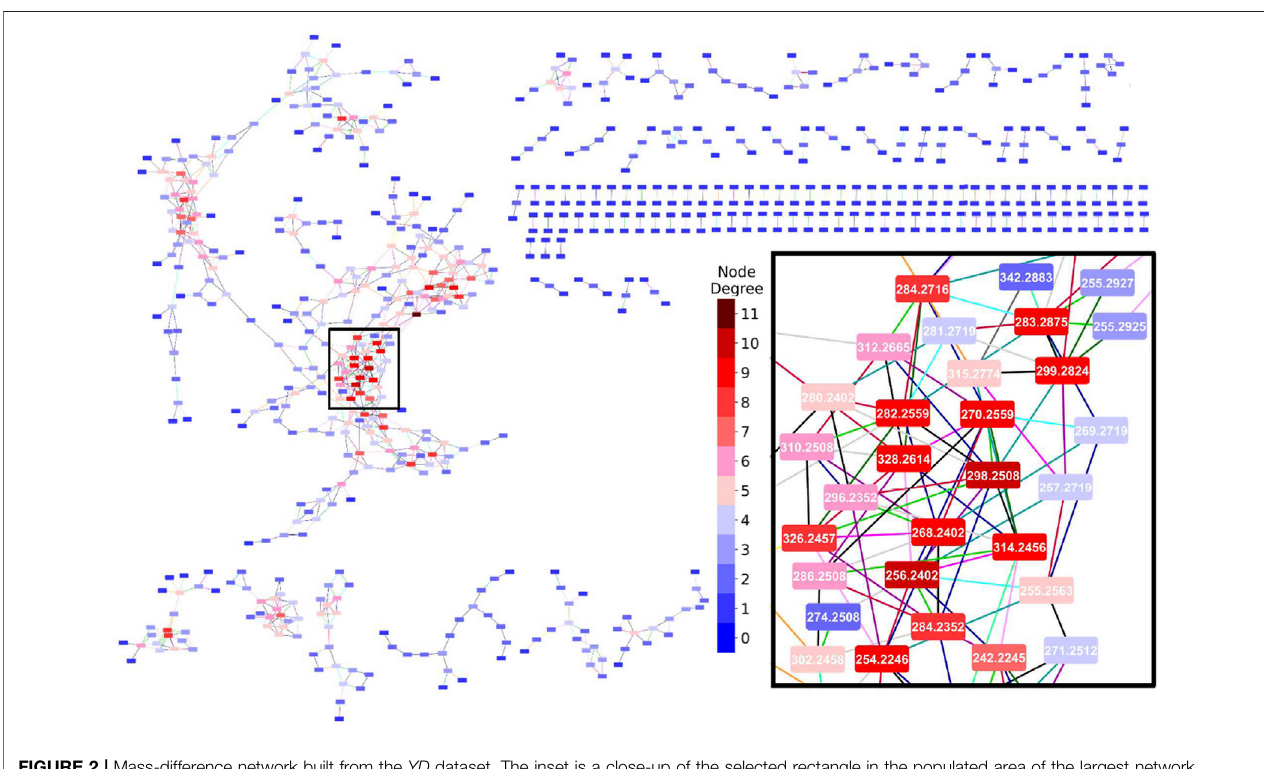
FIGURE 2 | Mass-difference network built from the YD dataset. The inset is a close-up of the selected rectangle in the populated area of the largest network